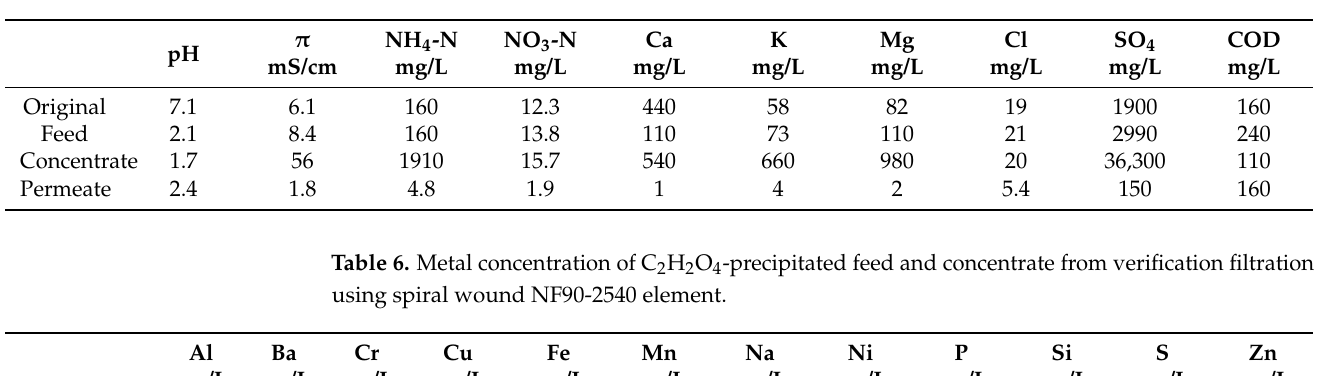
Table 5. Quality of C 2 H 2 O 4 -precipitated feed, permeate and concentrate in verification filtration using NF90-2540 element.